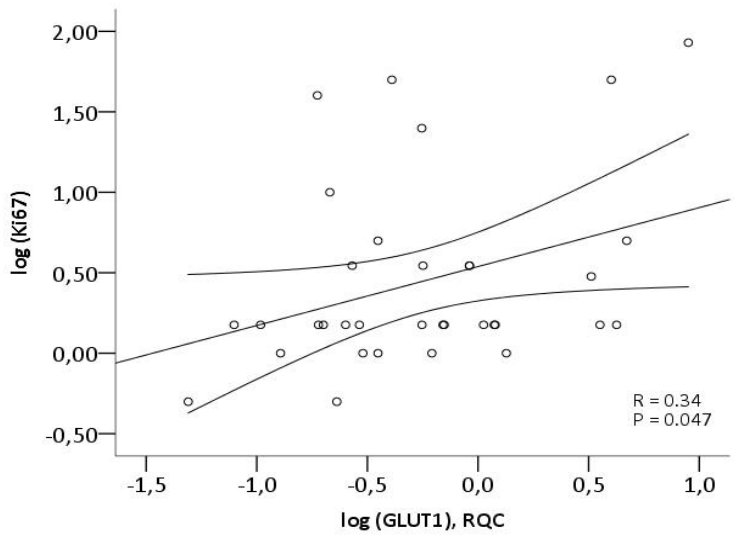
Figure 2. Correlation between GLUT1 gene expression and proliferation index in the NET group determined by qPCR and immunohistochemistry (IHC),